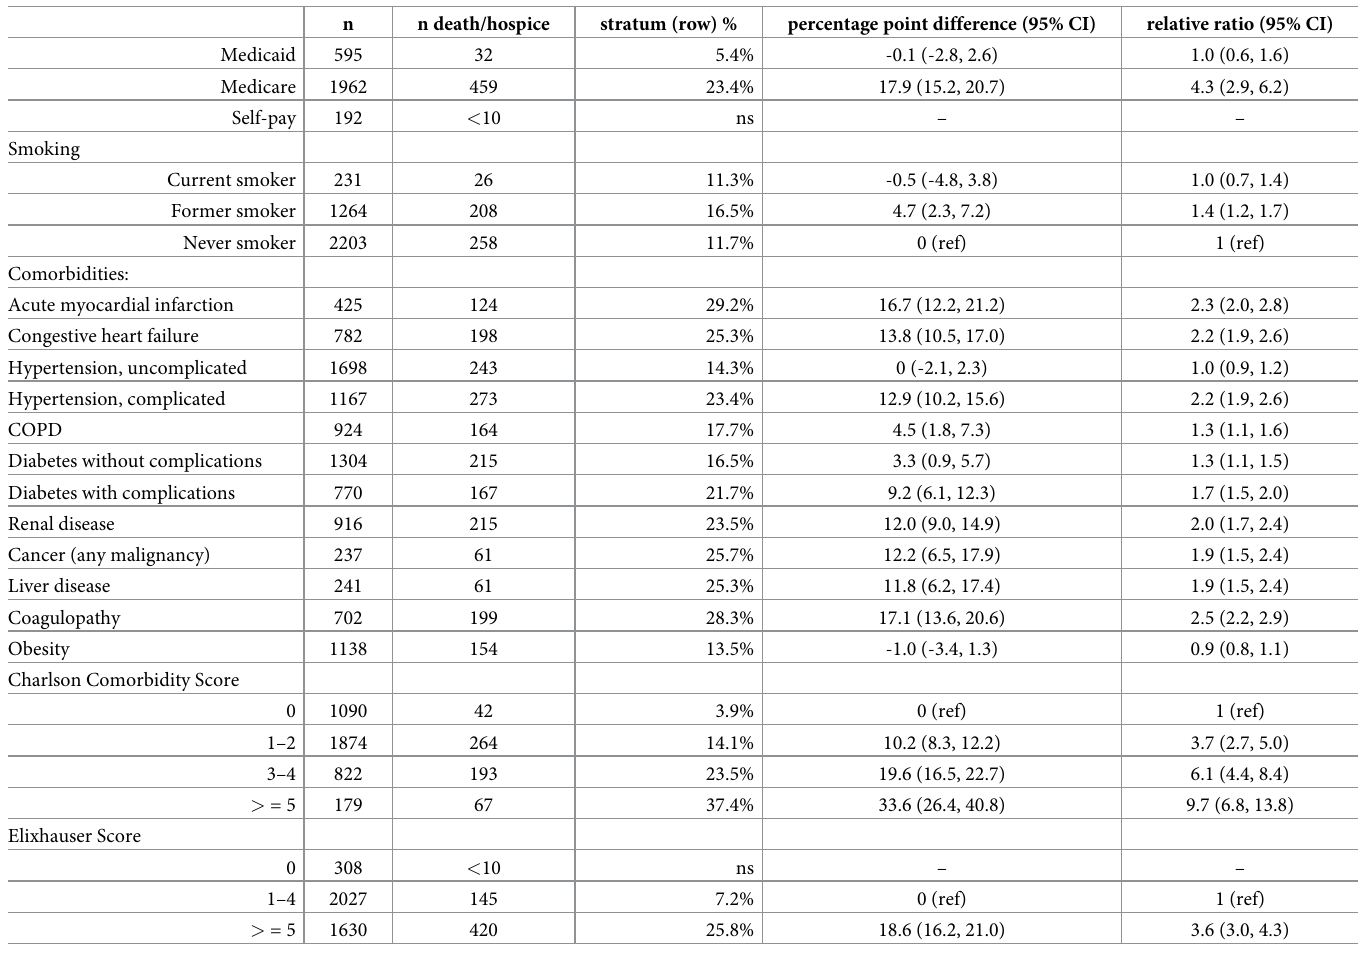
with acute myocardial infarction and coagulopathy had the highest percentage of death/hos- pice discharge, each at 29%. Further, patient groups with higher Charlson and Elixhauser comorbidity scores had higher percentages of death/hospice discharge. The majority of patients presented without fever ( < 100.4F), and 22% of patients had initial rural patient population as compared to the urban patient population (24% versus 21%). Median BMI was 30 and was similar across both urban and rural populations. Rural patients more commonly had lower lymphocyte counts and more commonly showed signs of hyperin- flammation via markers including C-reactive protein, D-dimer, and Procalcitonin. The percentage of patients who died/were discharged to hospice was higher in those with lower initial oxygen saturation values (Table 4). Death/discharge to hospice was less common for patients with increasingly higher BMI. Patient groups with lower lymphocyte counts had higher percentages of death/hospice discharge. For markers of a hyperinflammatory